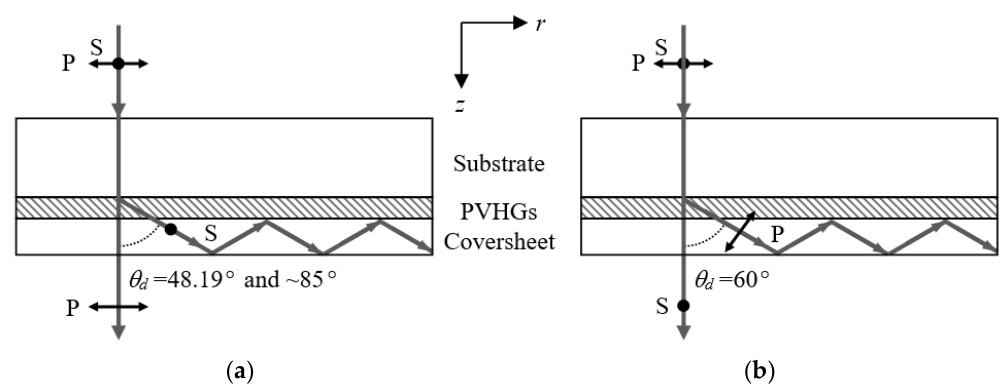
Figure 1. Structure and operating characteristics of polarization-selective volume hologram gratings (PVHGs) designed at ( a ) θ d = 48.19 ° and ~85 ° , and ( b ) θ d = 60 ° .